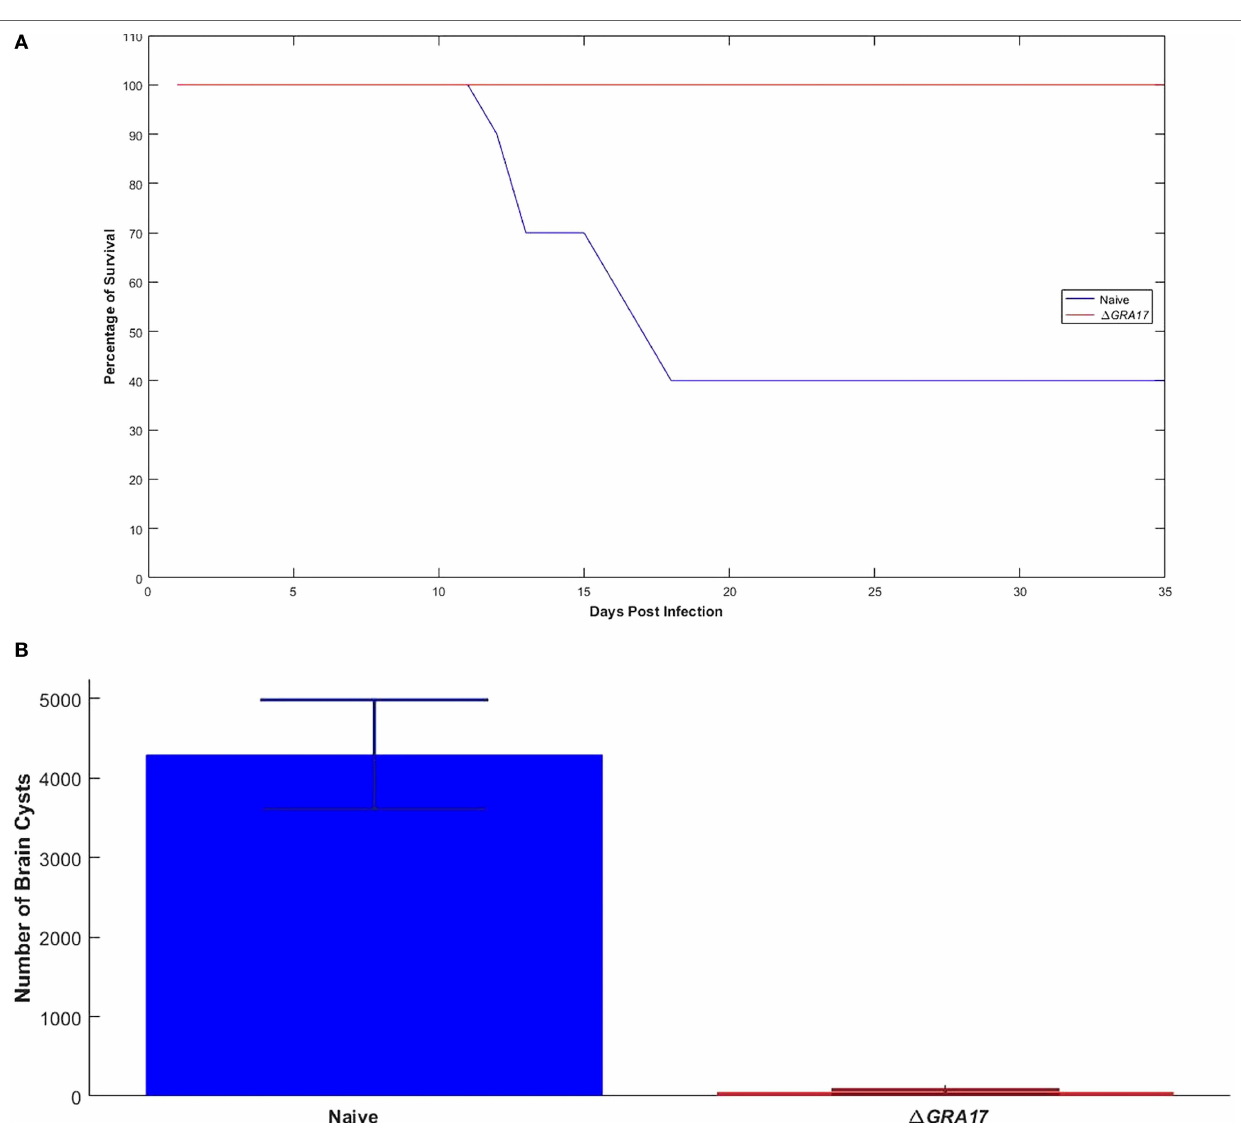
FigUre 8 | Immunization with Δ GRA17 promotes survival and inhibits brain cyst burden after infection. (a) Survival curves following challenge of Δ GRA17 - immunized mice with 20 cysts of Toxoplasma gondii type II Pru strain, compared with mock-immunized mice, 70 days after immunization. The survival of mice was monitored for 35 days. A Log-rank (Mantel–Cox) test demonstrated a significant difference between the immunized and control groups ( P = 0.0001). (B) Cyst burden in the brain of mice that survived to 35 days after challenge ( Δ GRA17 -immunized mice vs infected, non-immunized mice). Data points indicate means ±